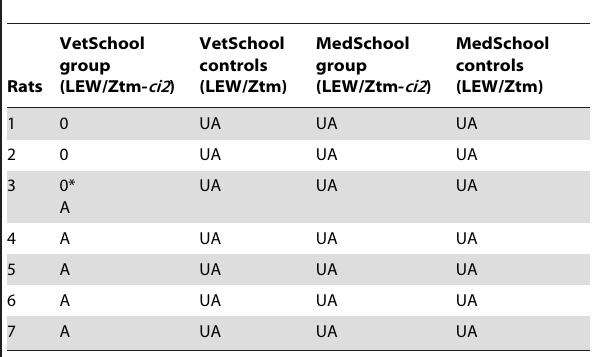
Table 1. Retinal phenotypes detected by electroretinography.